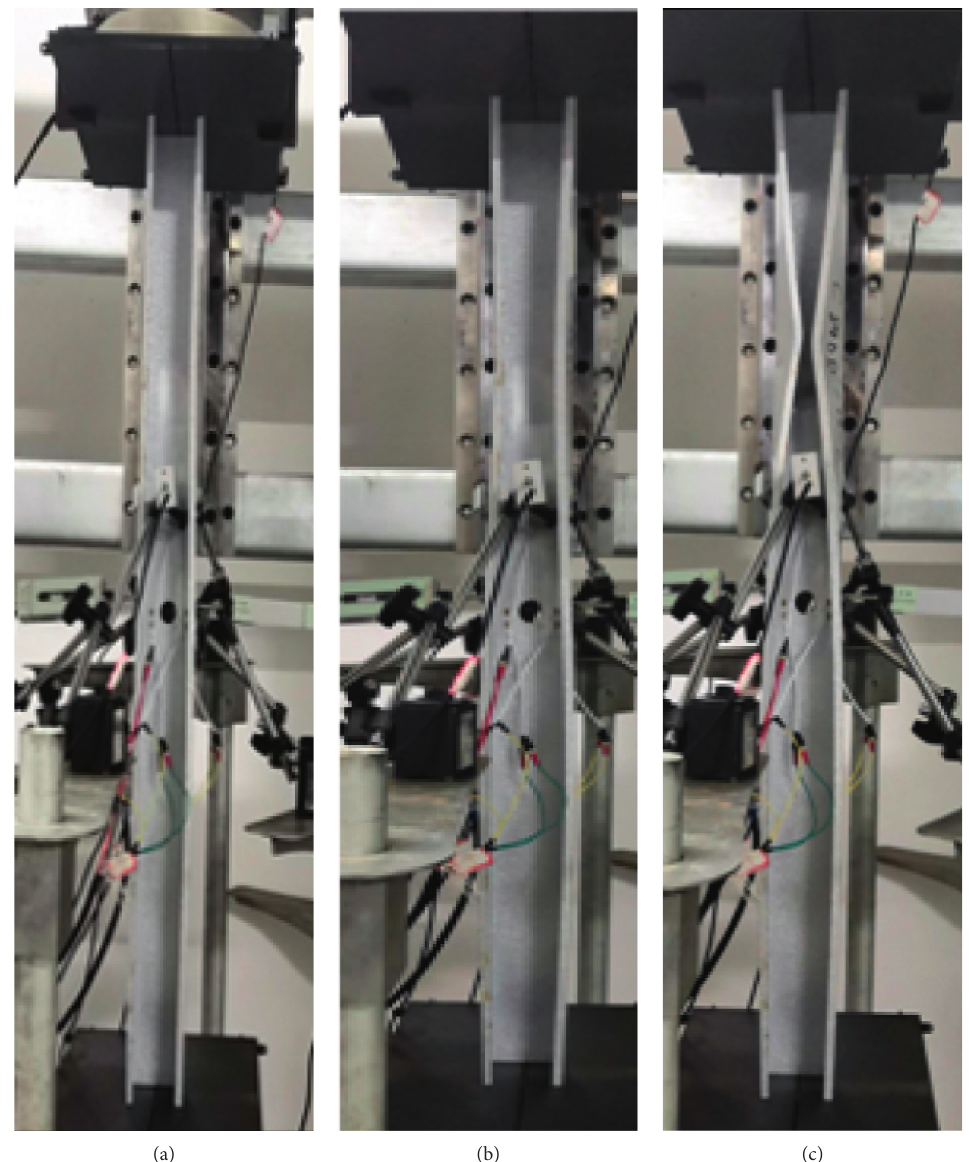
Figure 10: Buckling modes of the specimen C80-10-1H3-2. (a) Local buckling. (b) Distortional buckling. (c) Failure in interaction